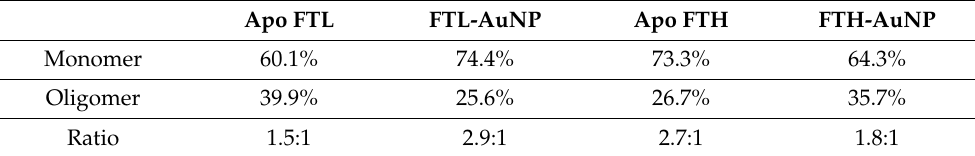
Table 2. Monomeric/oligomeric fraction analysis from size exclusion